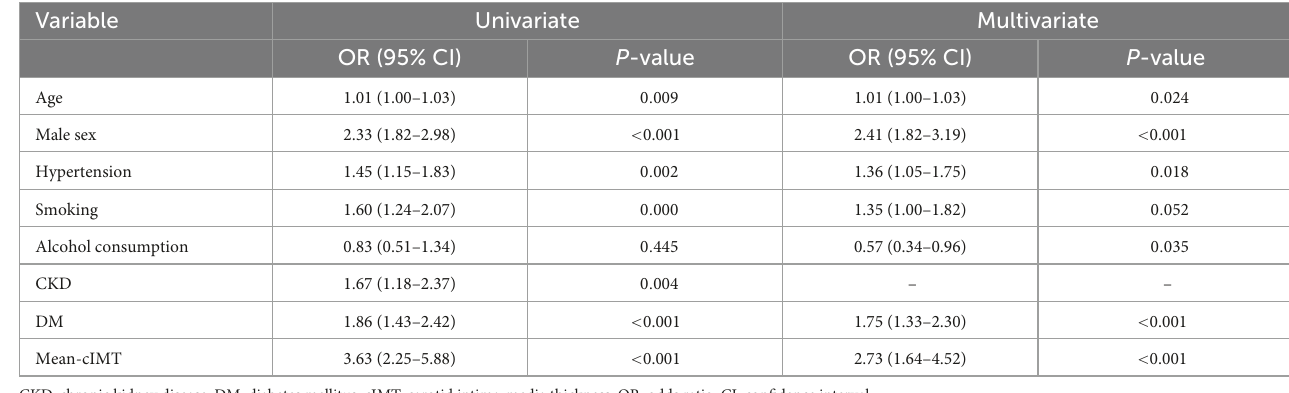
TABLE 2 Backward stepwise logistic analysis.